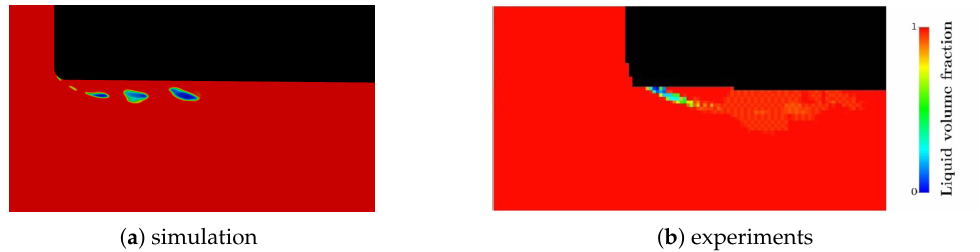
Figure 22. Code validation against experimental results: ( a ) numerical α v prediction; ( b ) vapor measurement.